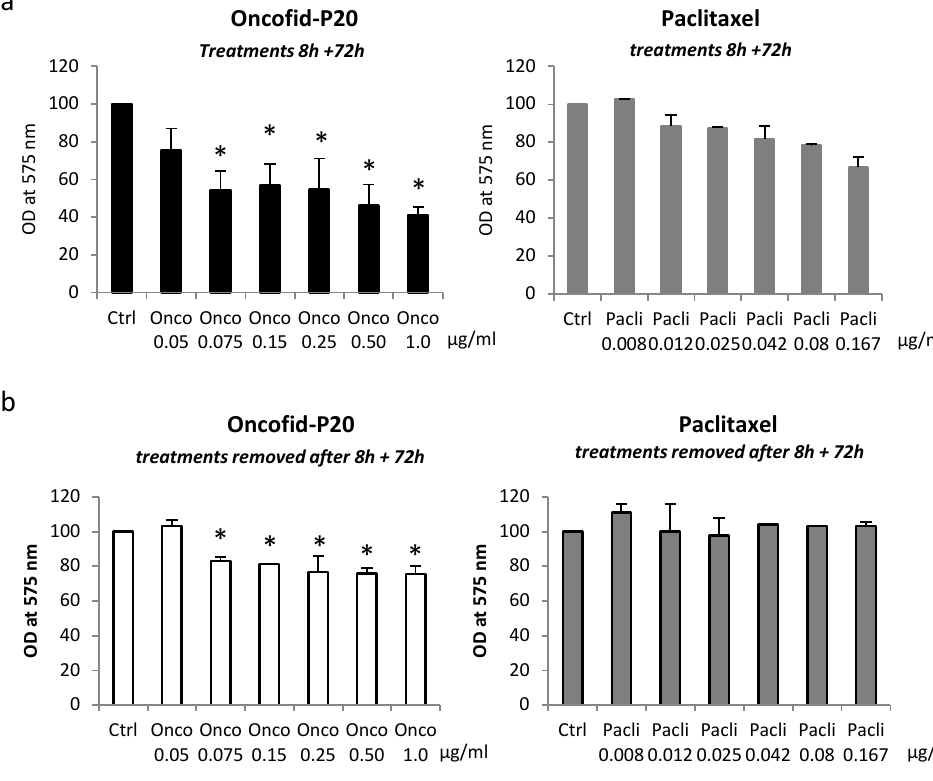
Figure 5. ( a ) MTT of NHFs treated for 8 h with Onco-P20 or PTX before the drug was washed out ( a ) or treated continuously for 72 h with identical treatments ( b ). Data represent the mean ± SD of three independent experiments performed in duplicate. Statistical significance expressing Onco-P20 versus PTX-treated cells is reported as * p <